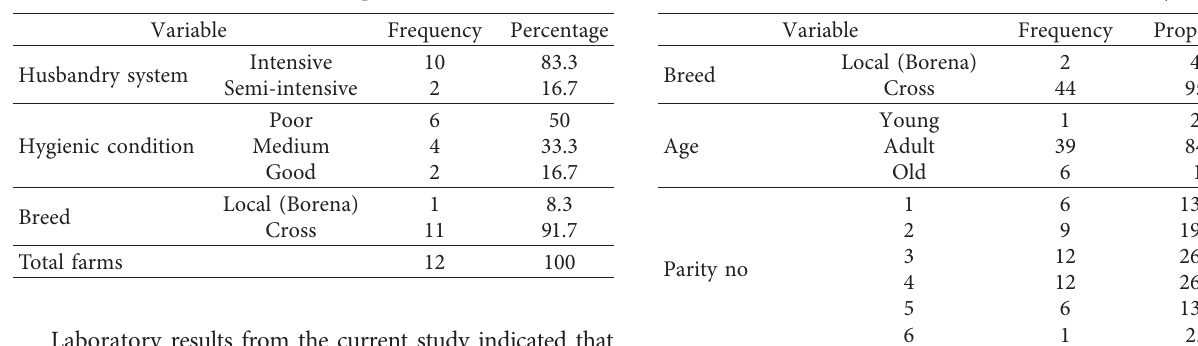
Table 3: Farm level description of factors. Table 4: Profiles of cows included in the